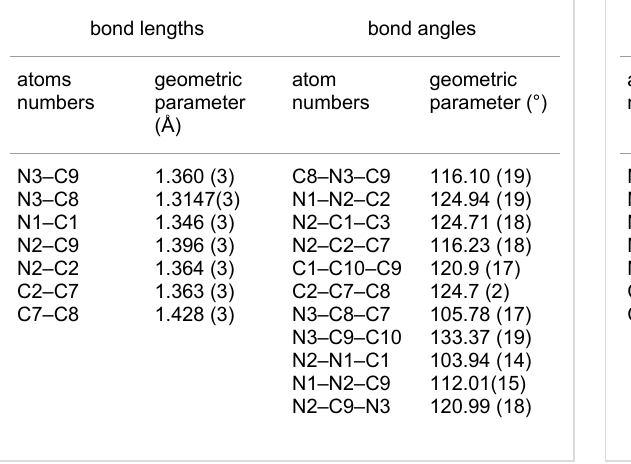
Table 4: Selected bond lengths and bond angles for compound 6g